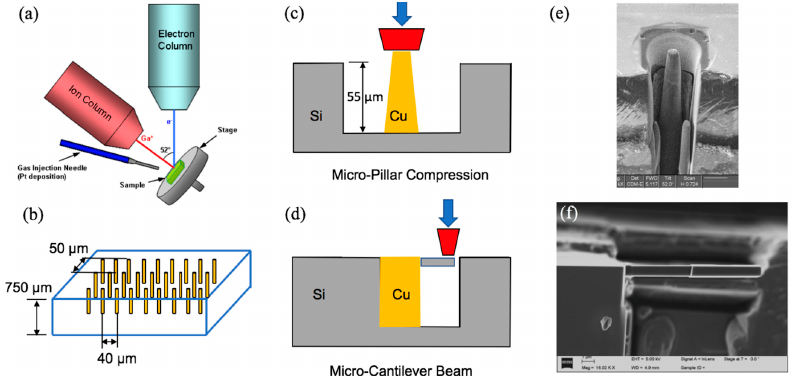
Figure 1. Through-silicon-via (TSV) specimens: ( a ) Focused ion beam scanning electron microscopy (FIB-SEM) dual beam system, ( b ) TSV in silicon substrate, schematics of ( c ) micro-pillar, ( d ) micro-